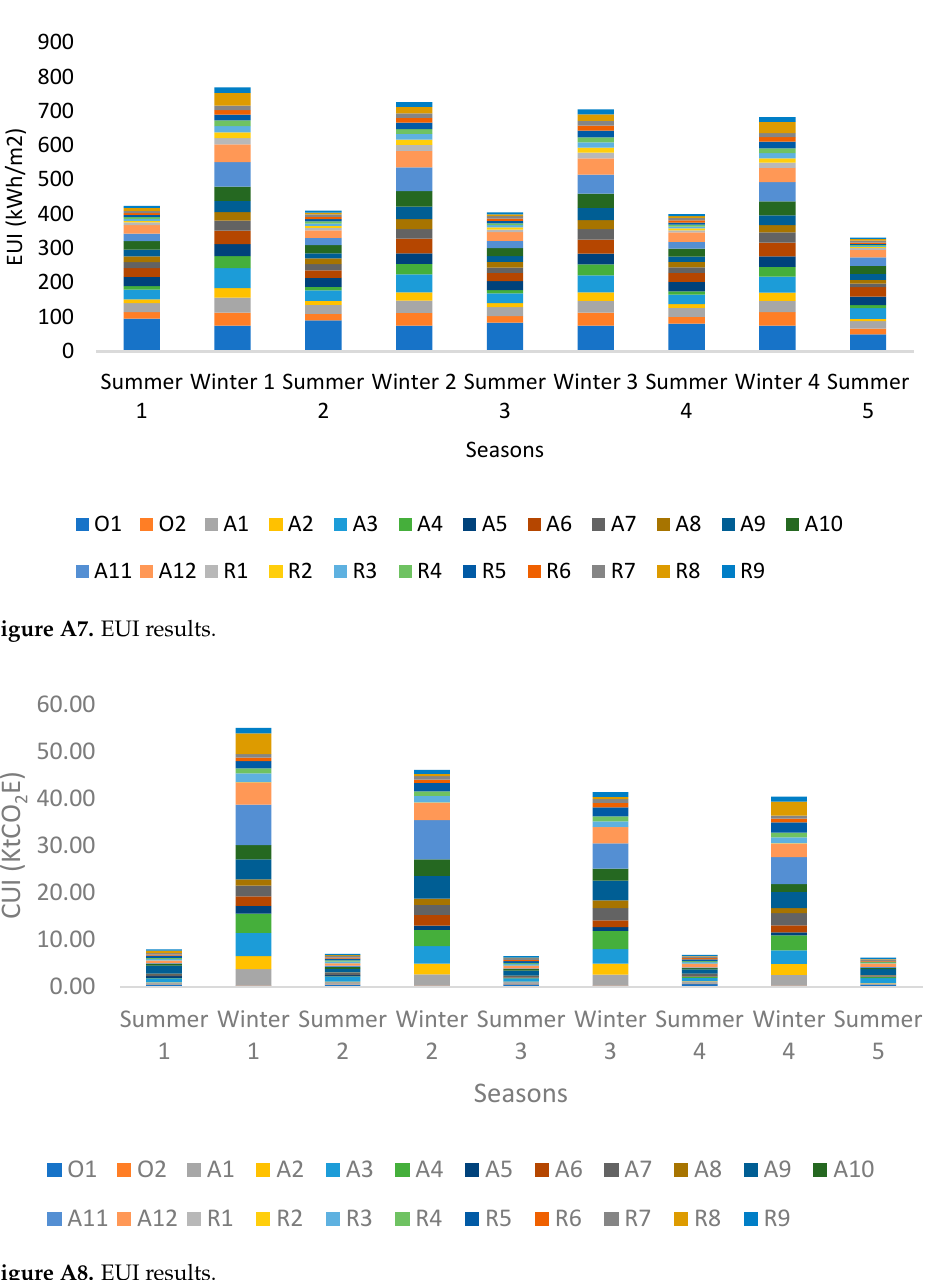
Figure A8. EUI results. Table A10. Conditional distribution by class.